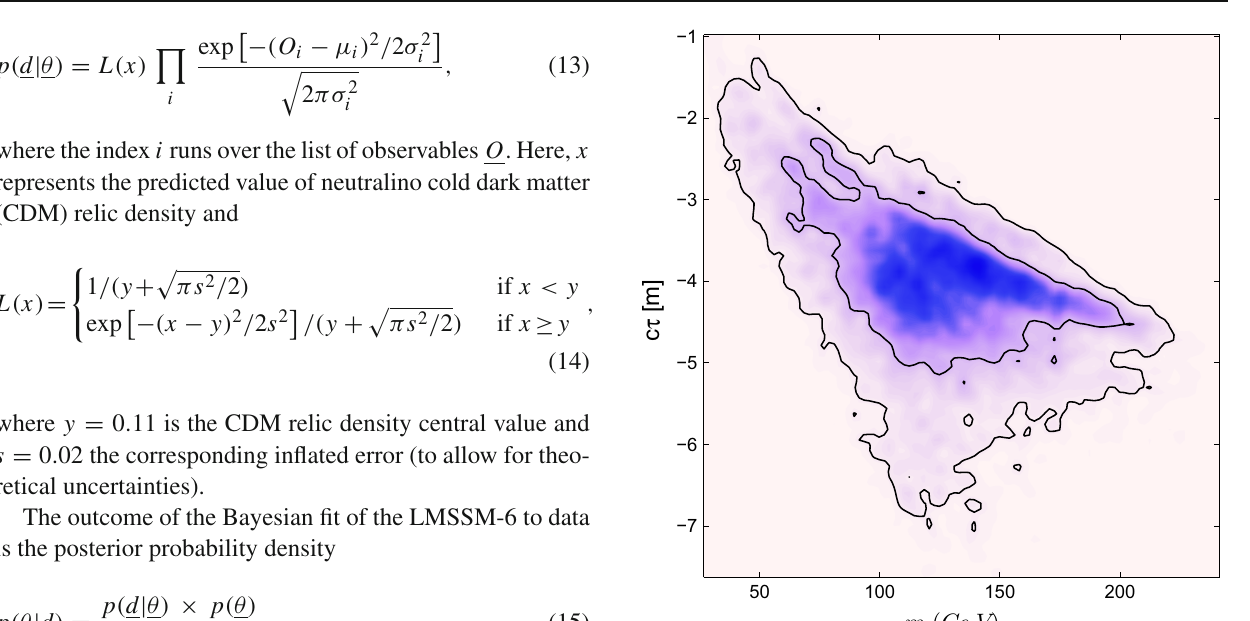
for instance, the CMS limits from searches with multijet final states [44,45] should apply for the LMSSM-6 gluinos.